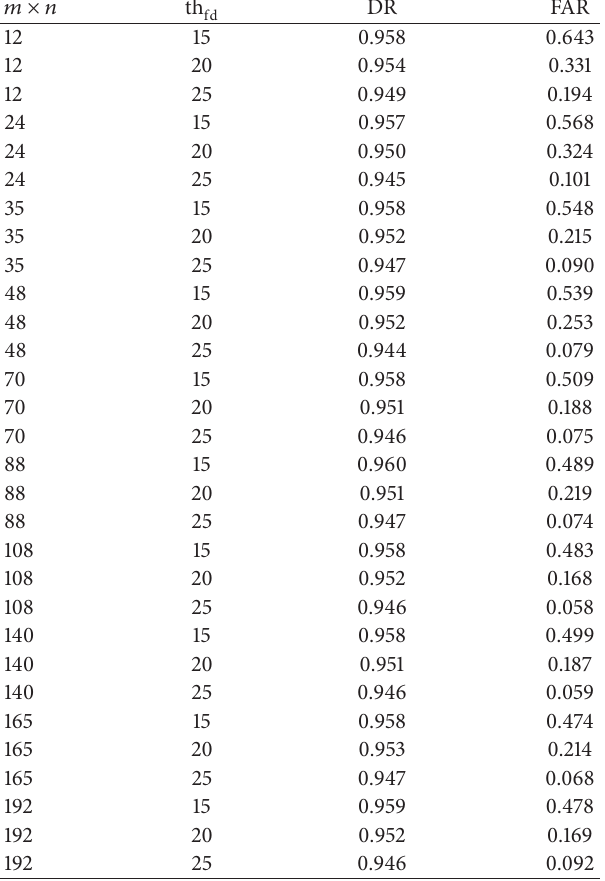
Table 6: Computation speed comparison of the proposed sys- tem with different software implementation using area-based and feature-based